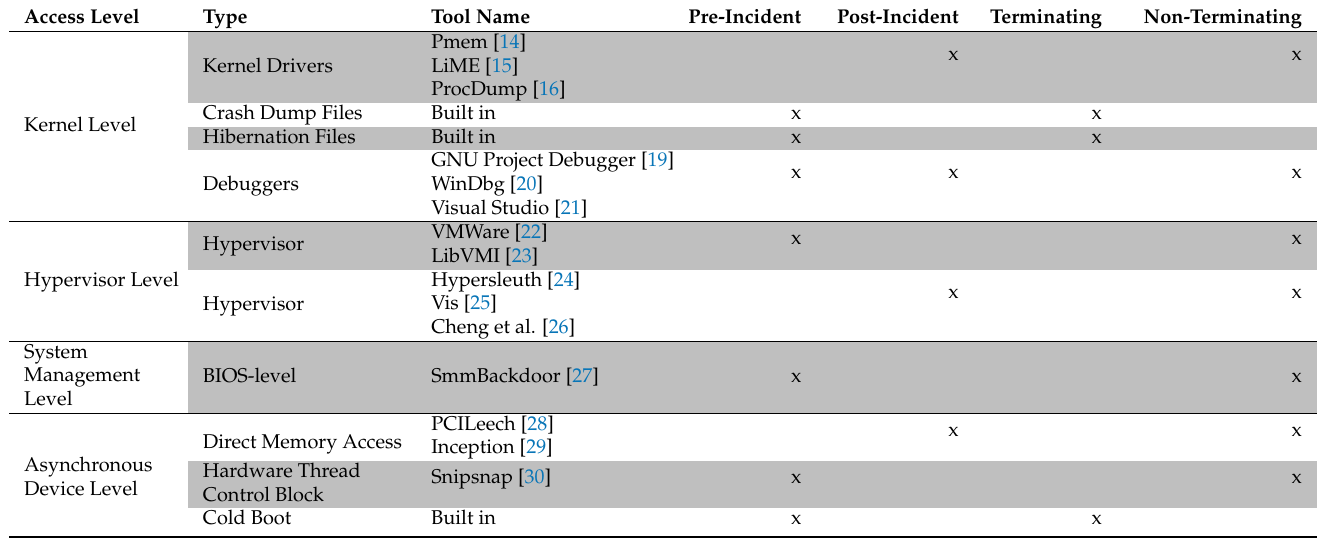
Table 1. A summary of memory acquisition tools according to the taxonomy [4]. An ’x’ in a column indicates that a tool’s category resides in that classification. An ’x’ is listed in both the Pre-Incident and Post-Incident column if a category of tools contains examples of both